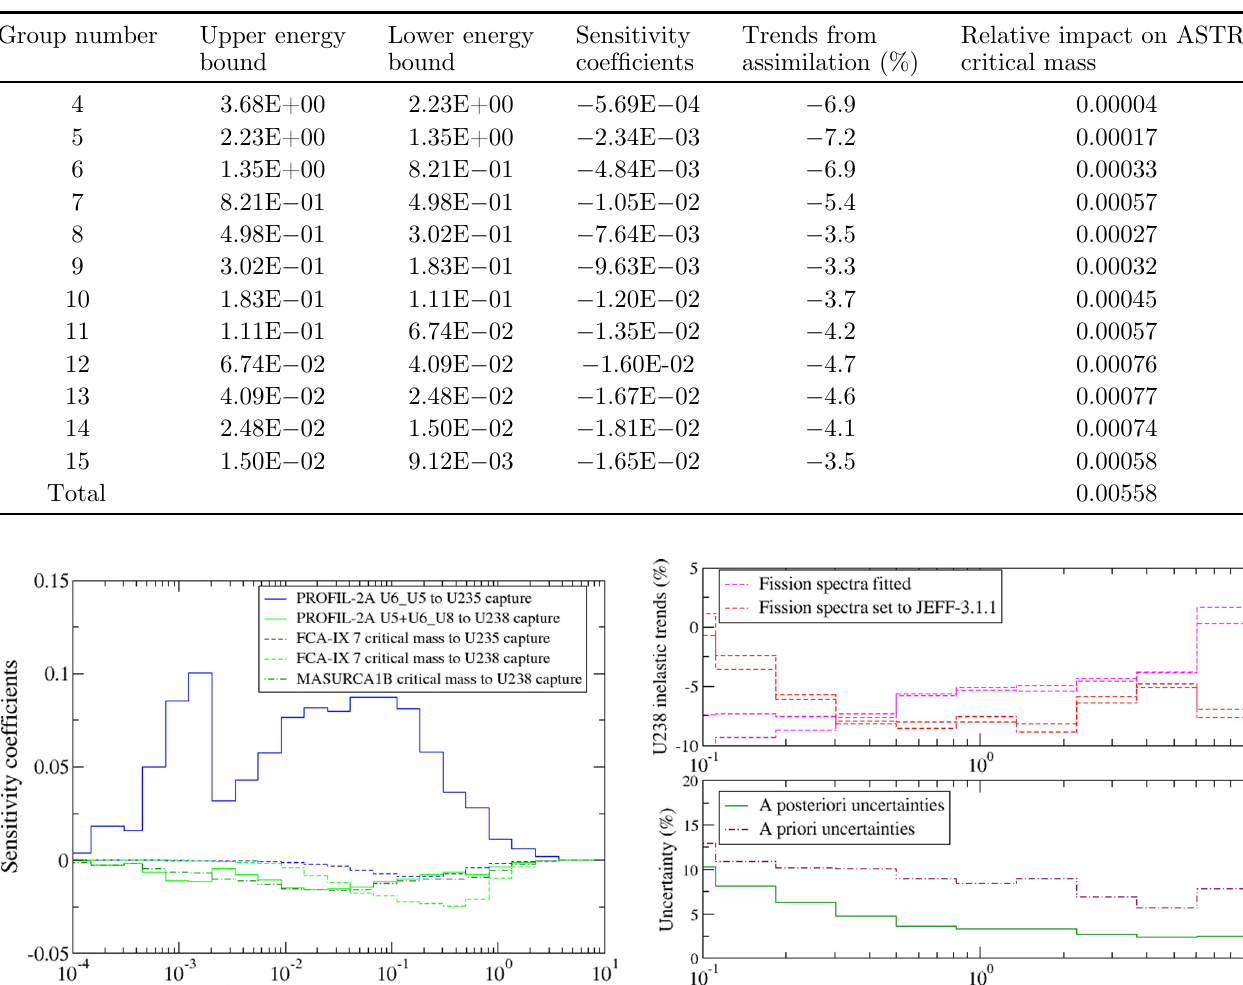
Table 5. Relative impact on ASTRID critical mass of the trends suggested by assimilation when fi ssions spectra are set to JEFF-3.1.1 evaluations. Only trends superior to posterior uncertainties were considered.